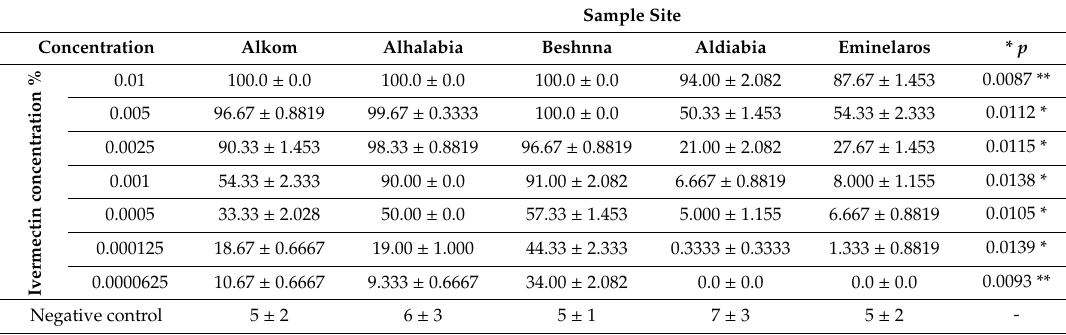
Table 2. The mortality rate of larvae treated with di ff erent concentrations of ivermectin in the surveyed